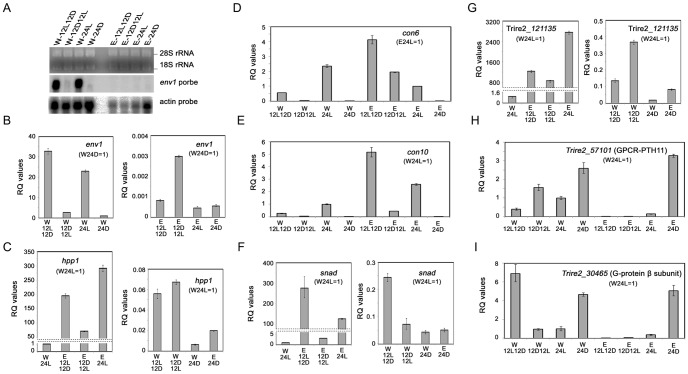
Transcription levels of putative genes involved in conidiation and sexual potency.Total RNAs were extracted from 8 different experimental conditions as indicated. The quality of extracted RNA samples was further analyzed with the RNA 6000 Nano kit by Agilent 2100 Bioanalyzer (see Materials and Methods). (A) Northern blots analysis of act1 (actin) and env1 transcription. The denaturing RNA agarose gel was stained with ethidium bromide, the 18S rRNA and 28S rRNA bands were clearly visible in the intact RNA samples. (B–H) qRT-PCR. Relative transcript abundance of representative genes in sexually potent and impotent conditions. Data were given as relative quantitative (RQ) values to one of the eight conditions as indicated. The transcripts of the ribosome protein gene rpl6e were used for normalization of the qRT-PCR data [43].